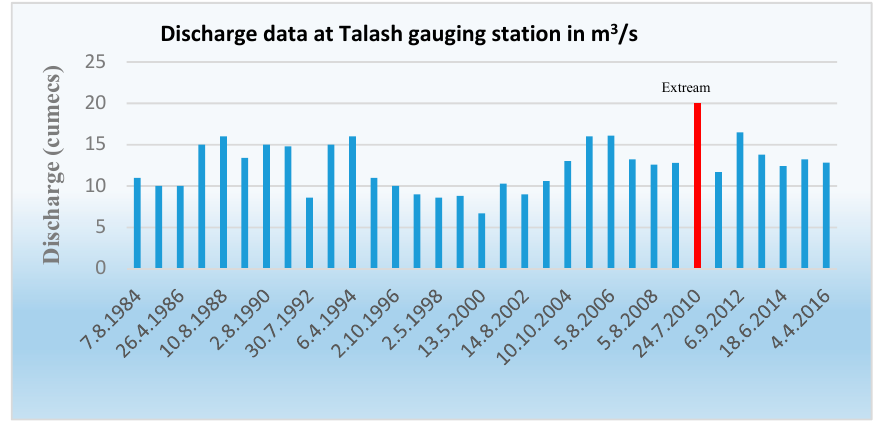
Figure 8. Highest discharge recorded at Talash gauging station in cubic meter per second.